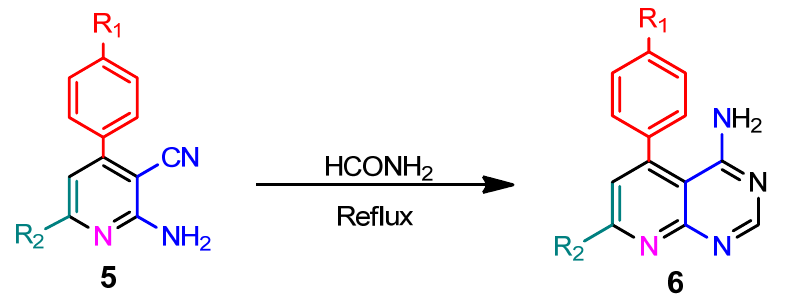
Table 3. Synthesis of pyrido[2,3- d ]pyrimidine derivative 6